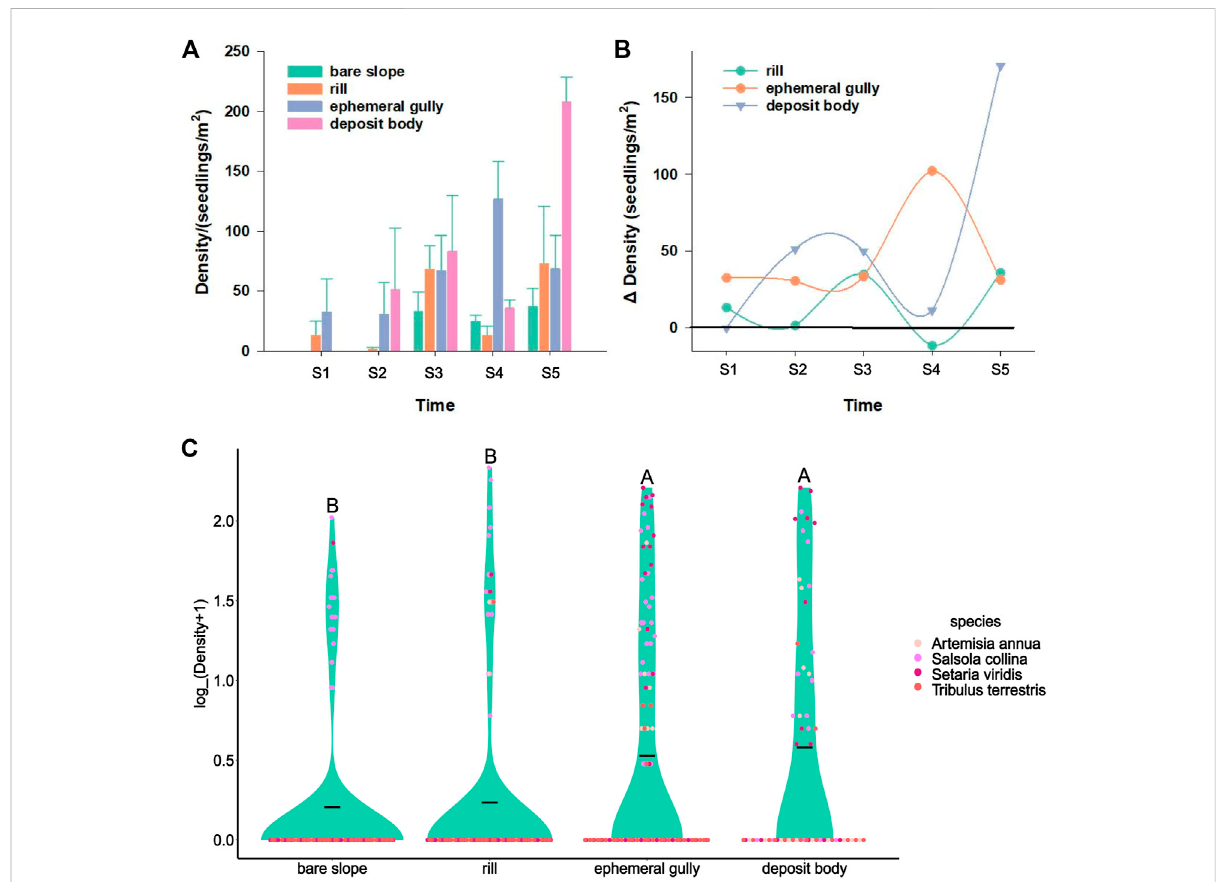
FIGURE 2 Temporal dynamics and total seedling density in the four micro-topographies. (A) Seedling densities in each micro-topography. (B) D-value of seedling density in each micro-topography compared with the bare slope. (C) Overall seedling density of the fi ve investigations in the four micro- topographies. The black segment in each violin graph represents the mean number, and different letters (A,B) above each graph indicate signi fi cant differences between the erosion micro-topographies at p < 0.01 (Student ’ s